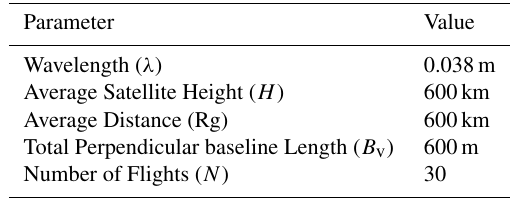
Table 1. Simulation parameter.